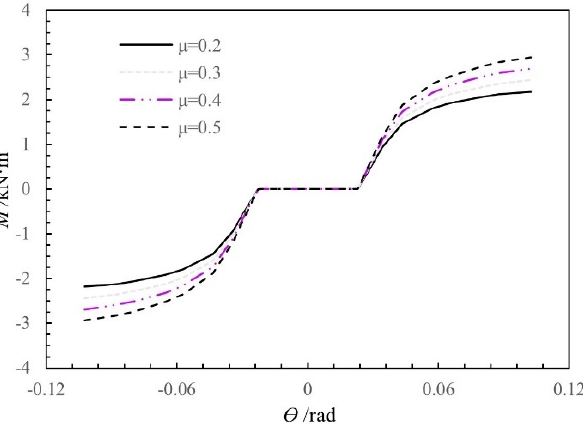
Figure 20. Moment-rotation curves of SMTJ/WP at different friction coefficients of wood.